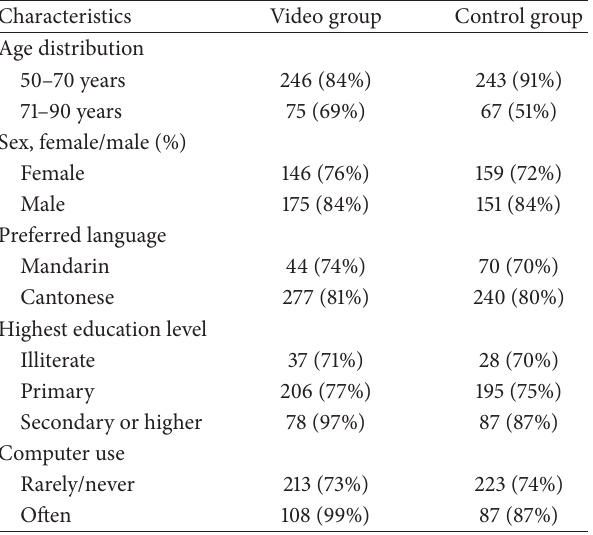
Table 3: The influence of age distribution, gender, preferred lan- guage, highest education level, and computer use on the number of correct responses out of the 10-item questionnaire (accuracy rate) in each